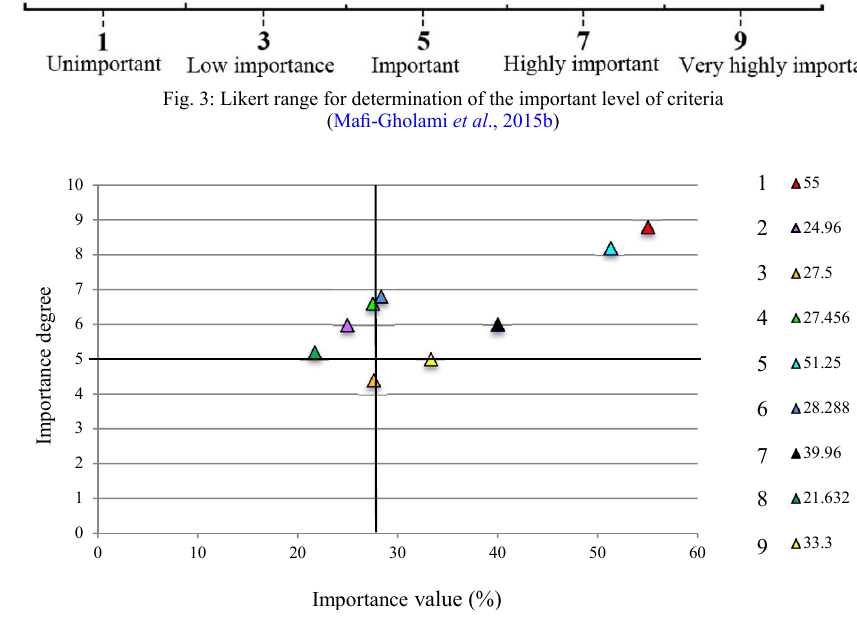
Fig. 4: Importance diagram of the criteria of site selection for desalination